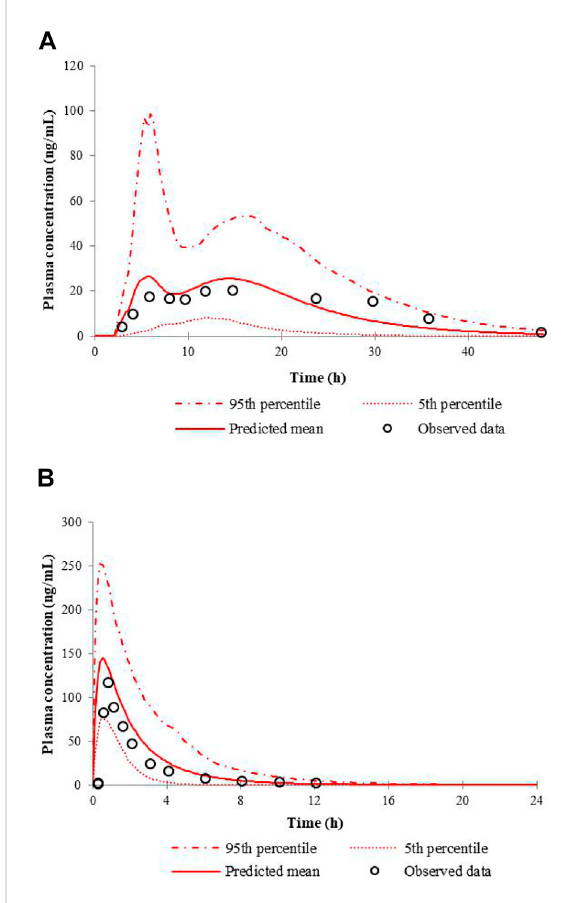
FIGURE 1 Predicted and observed mean plasma concentration-time curves of nifedipine following a single administration of 60 mg nifedipine CR tablet (A) or 20 mg nifedipine IR tablet (B) in healthy